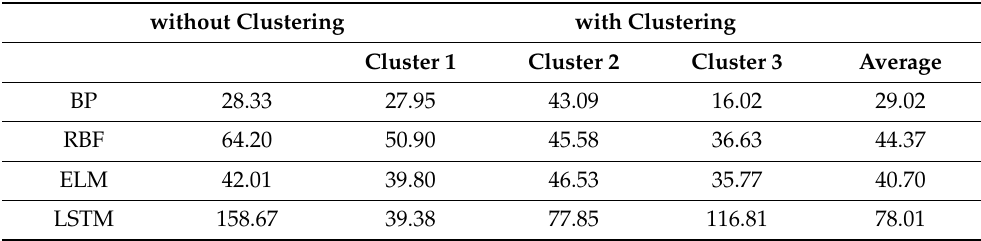
Table 6. MAE of solar radiation forecast errors in autumn.